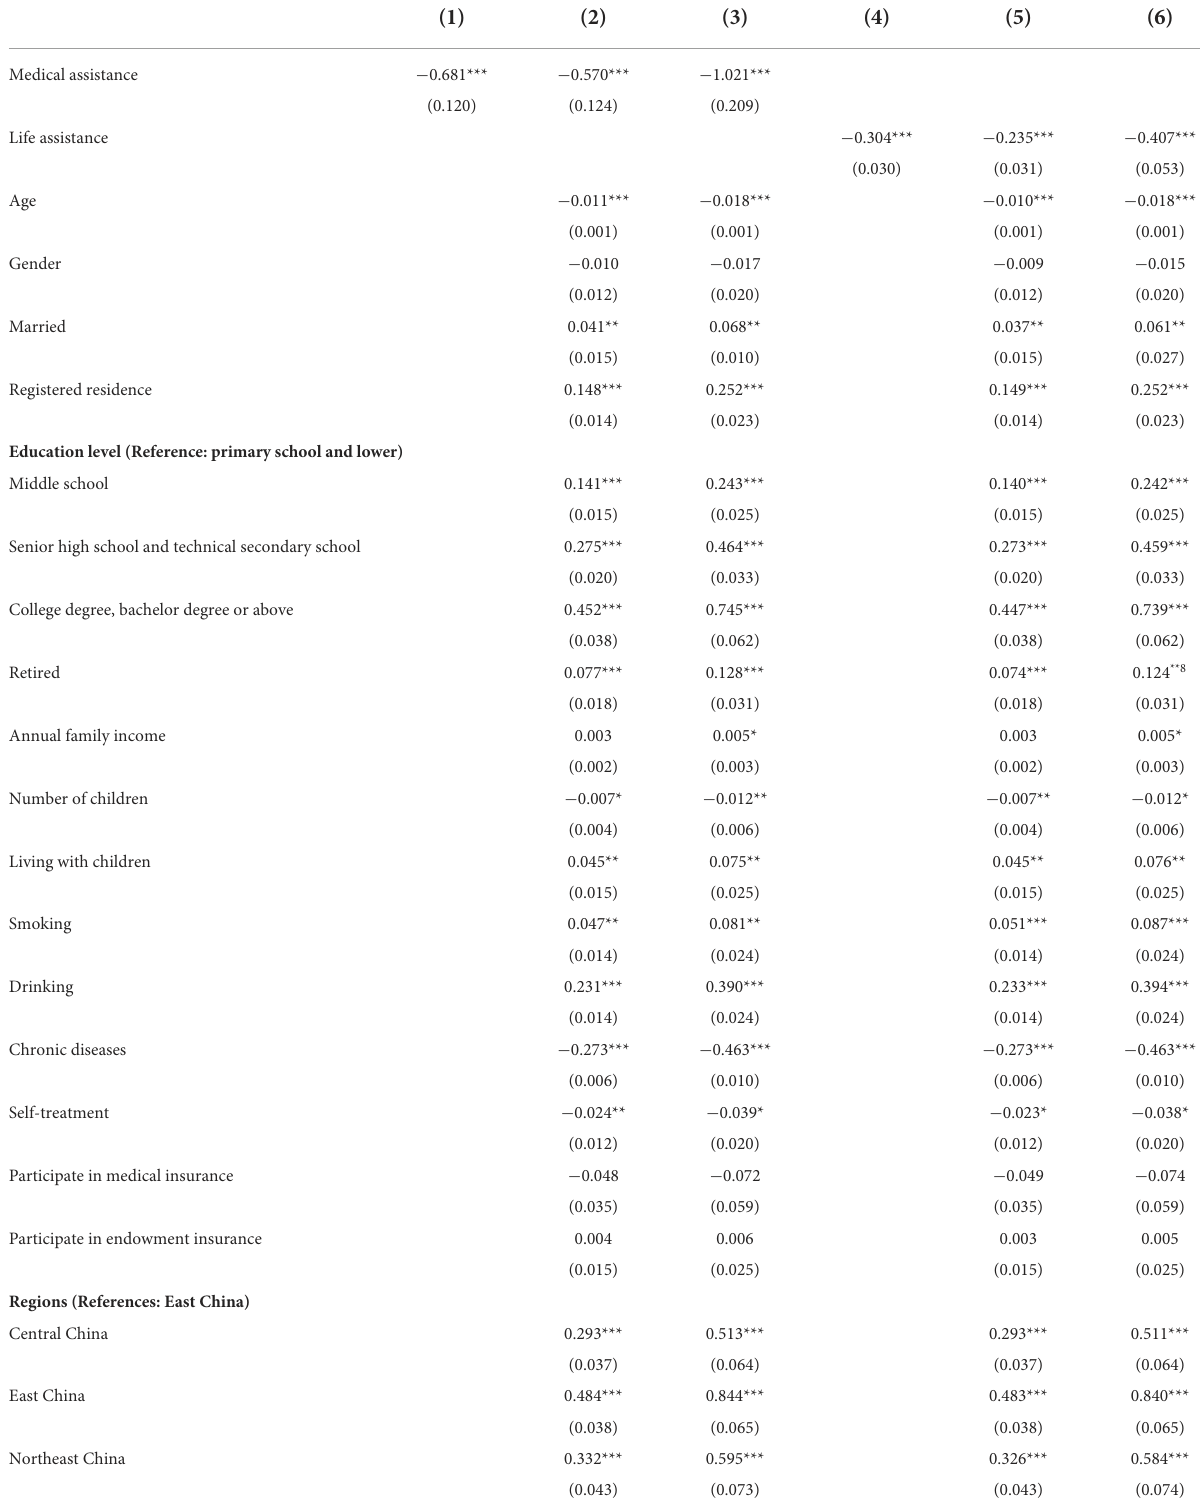
TABLE 2 Standard regression